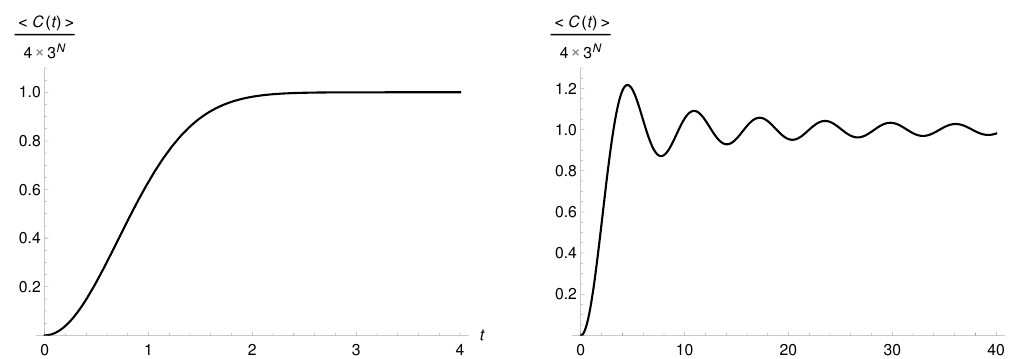
Figure 6 . Normalized h C ( t ) i J =